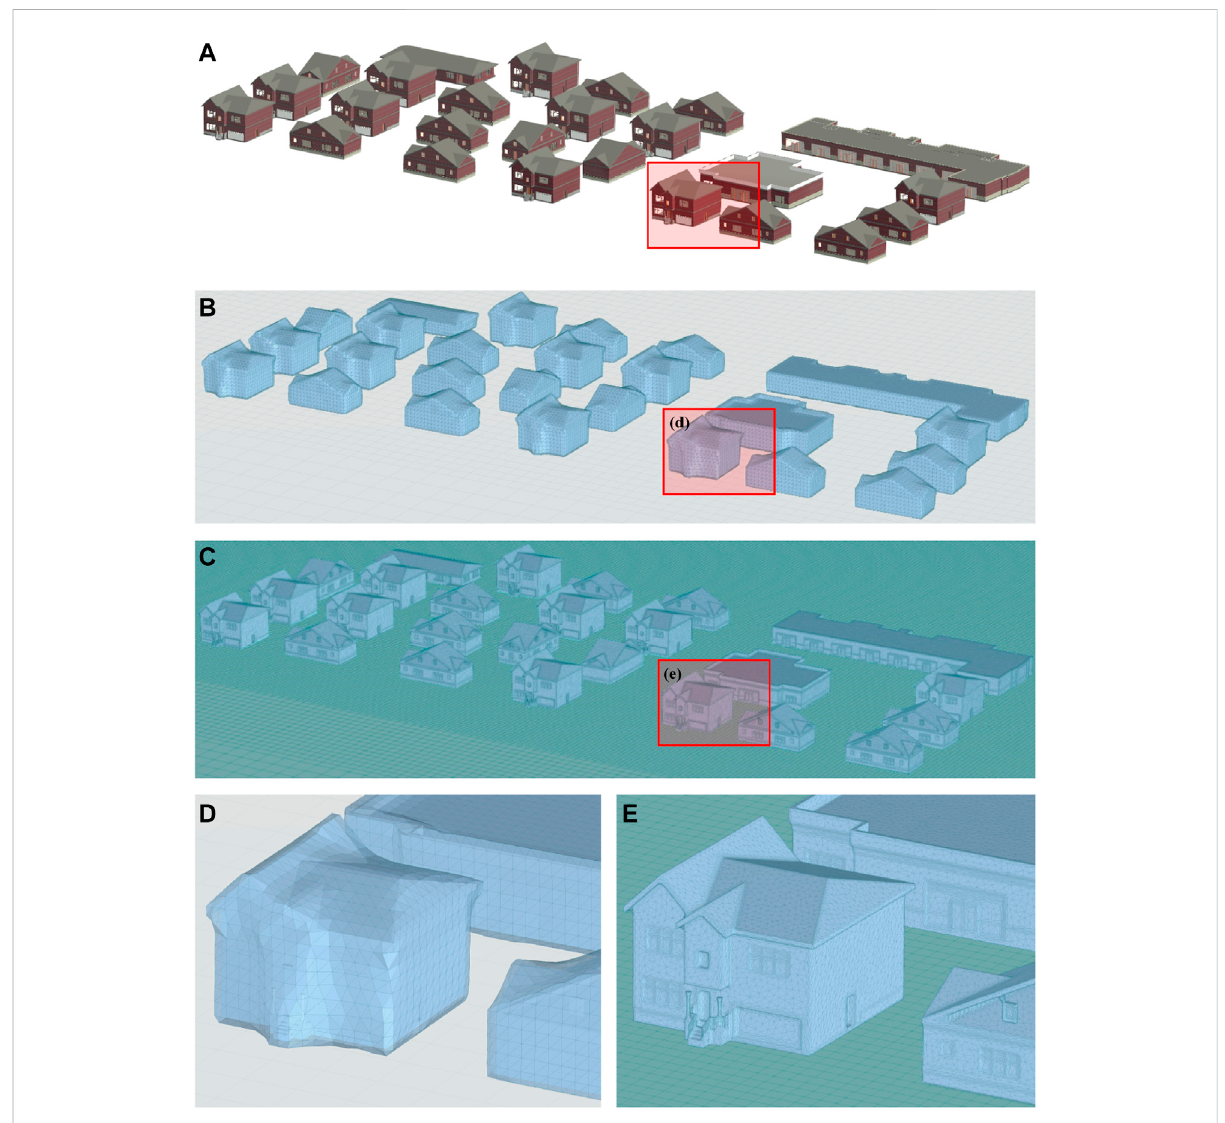
FIGURE 5 Community-level geometry generation for buildings (A) BIM model of the community; (B) Low-resolution geometry; (C) High-resolution geometry; (D – E) Close-up views on buildings showing the size of the mesh used to generate the geometry.